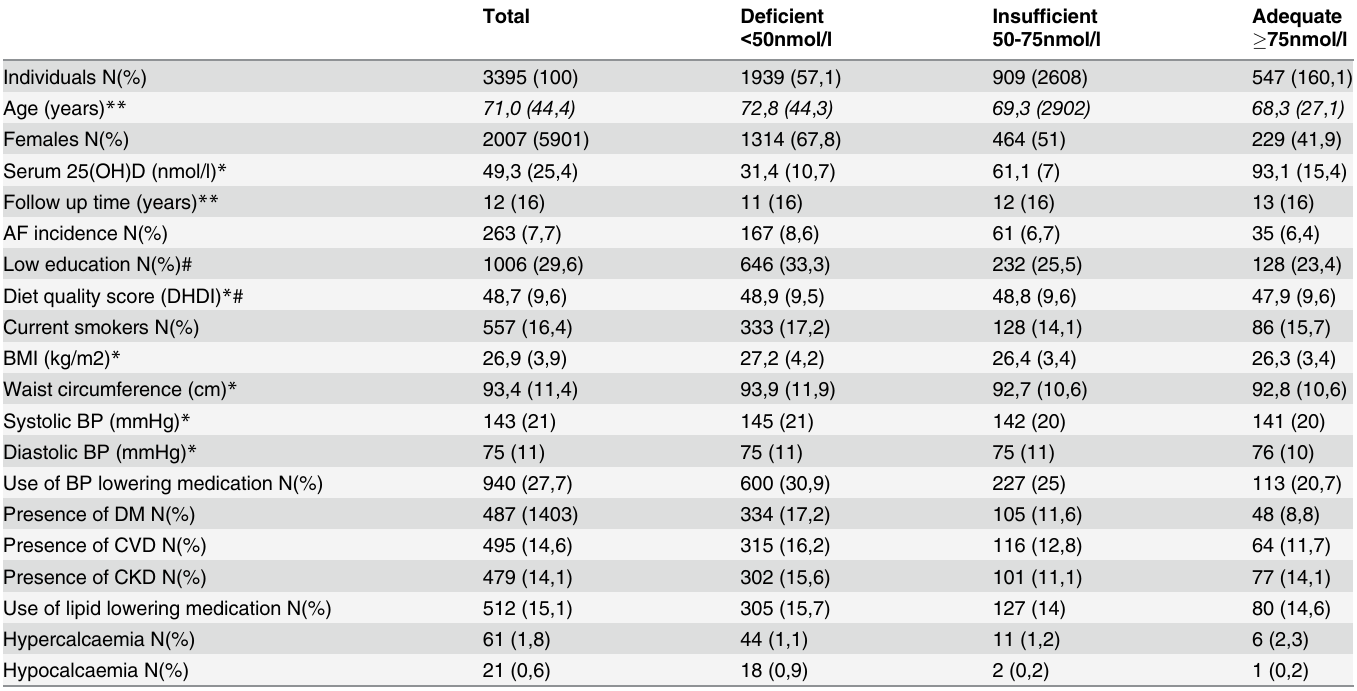
Table 1. Baseline characteristics of study population according to vitamin D